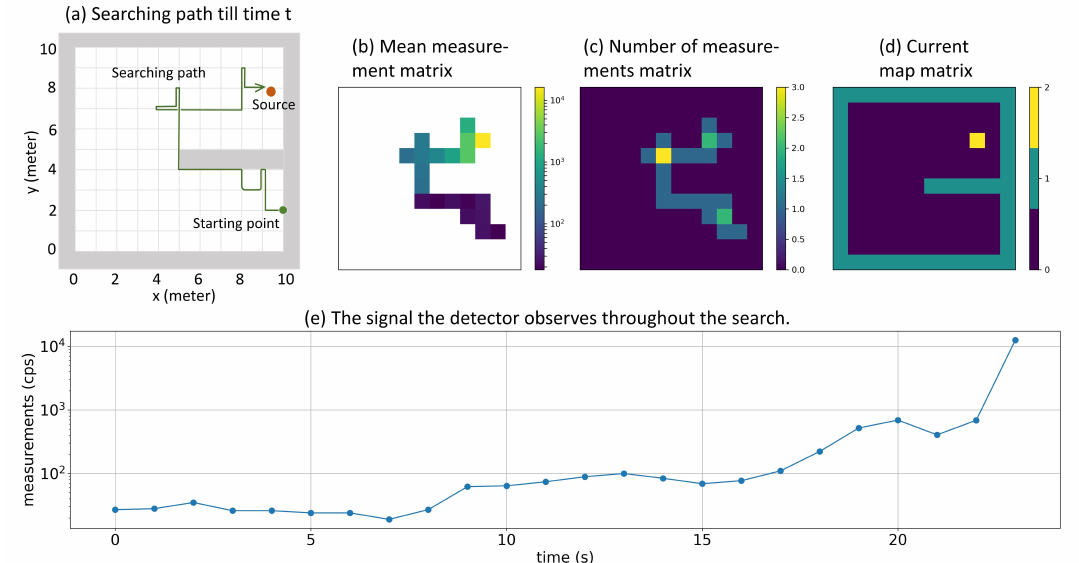
Figure 3. Representing the searching history using Mean measurement matrix, Number of measurements matrix, and Current map matrix. Plot ( a ) shows an example of a searching history. In plot ( b ), color represents the intensity of mean radiation measurements for each position. In plot ( c ), color represents the number of measurements been taken so far at each position. In plot ( d ), yellow represents the detector’s current position, green represents boundaries and walls, and blue represents accessible positions. Plot ( e ) represents the signal that the detector observed throughout the